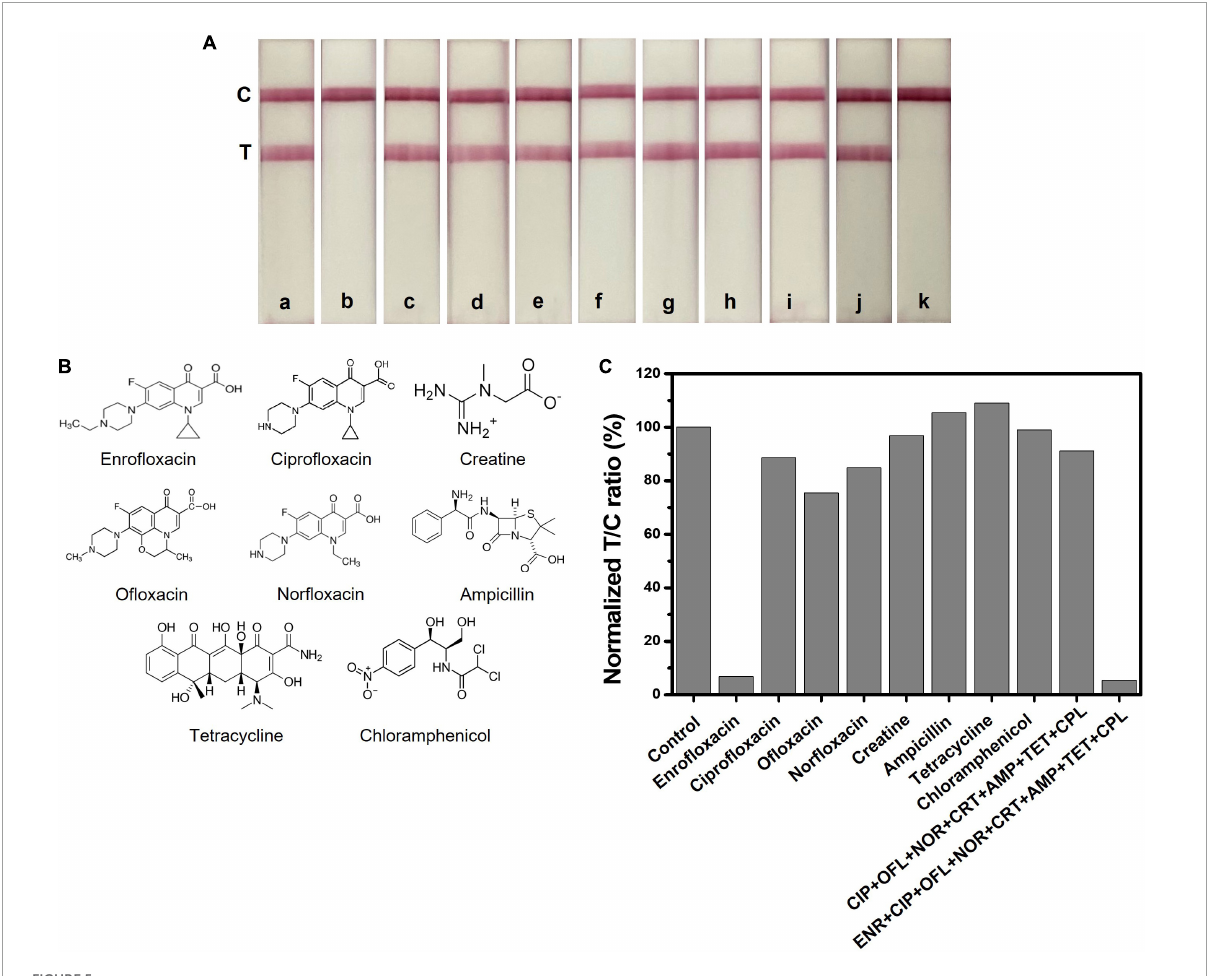
FIGURE5 Selectivity test of ENR and interference molecules at a concentration of 50 ng/ml. (A) Images of the LFIA test strips with ENR and interference molecules. a: control, b: enrofloxacin (ENR), c: ciprofloxacin (CIP), d: ofloxacin (OFL), e: norfloxacin (NOR), f: creatine, g: ampicillin (AMP), h: tetracycline (TET), i: chloramphenicol (CPL), j: mixture of CIP+ OFL+ NOR+ CRT+ AMP+ TET+ CPL and k: mixture of ENR+ CIP+ OFL+ NOR + CRT+ AMP+ TET+ CPL. (B) Chemical structures of ENR and other interference molecules. (C) The normalized T/C ratio of LFIA strips produced by the ImageJ program.